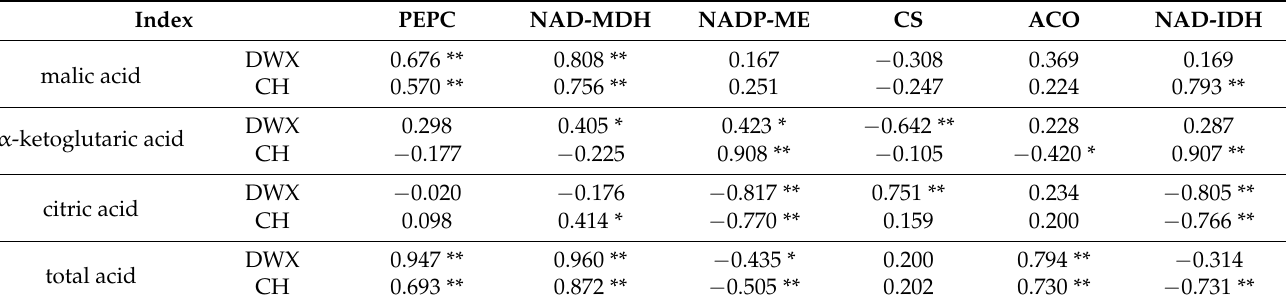
Table 3. Correlation analysis of organic acids with related enzyme activities.